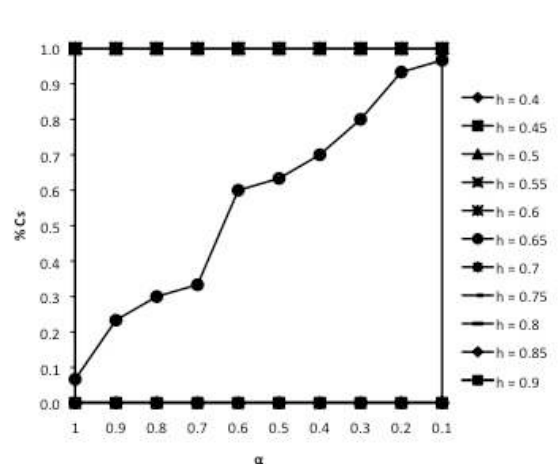
Fig. 6. Proportion of Cs for the SH game on SWNs with φ = 0 . 01 and with K = 1 / 4. Cs and Ds only coexist for h = 0 . 65. The average D value is